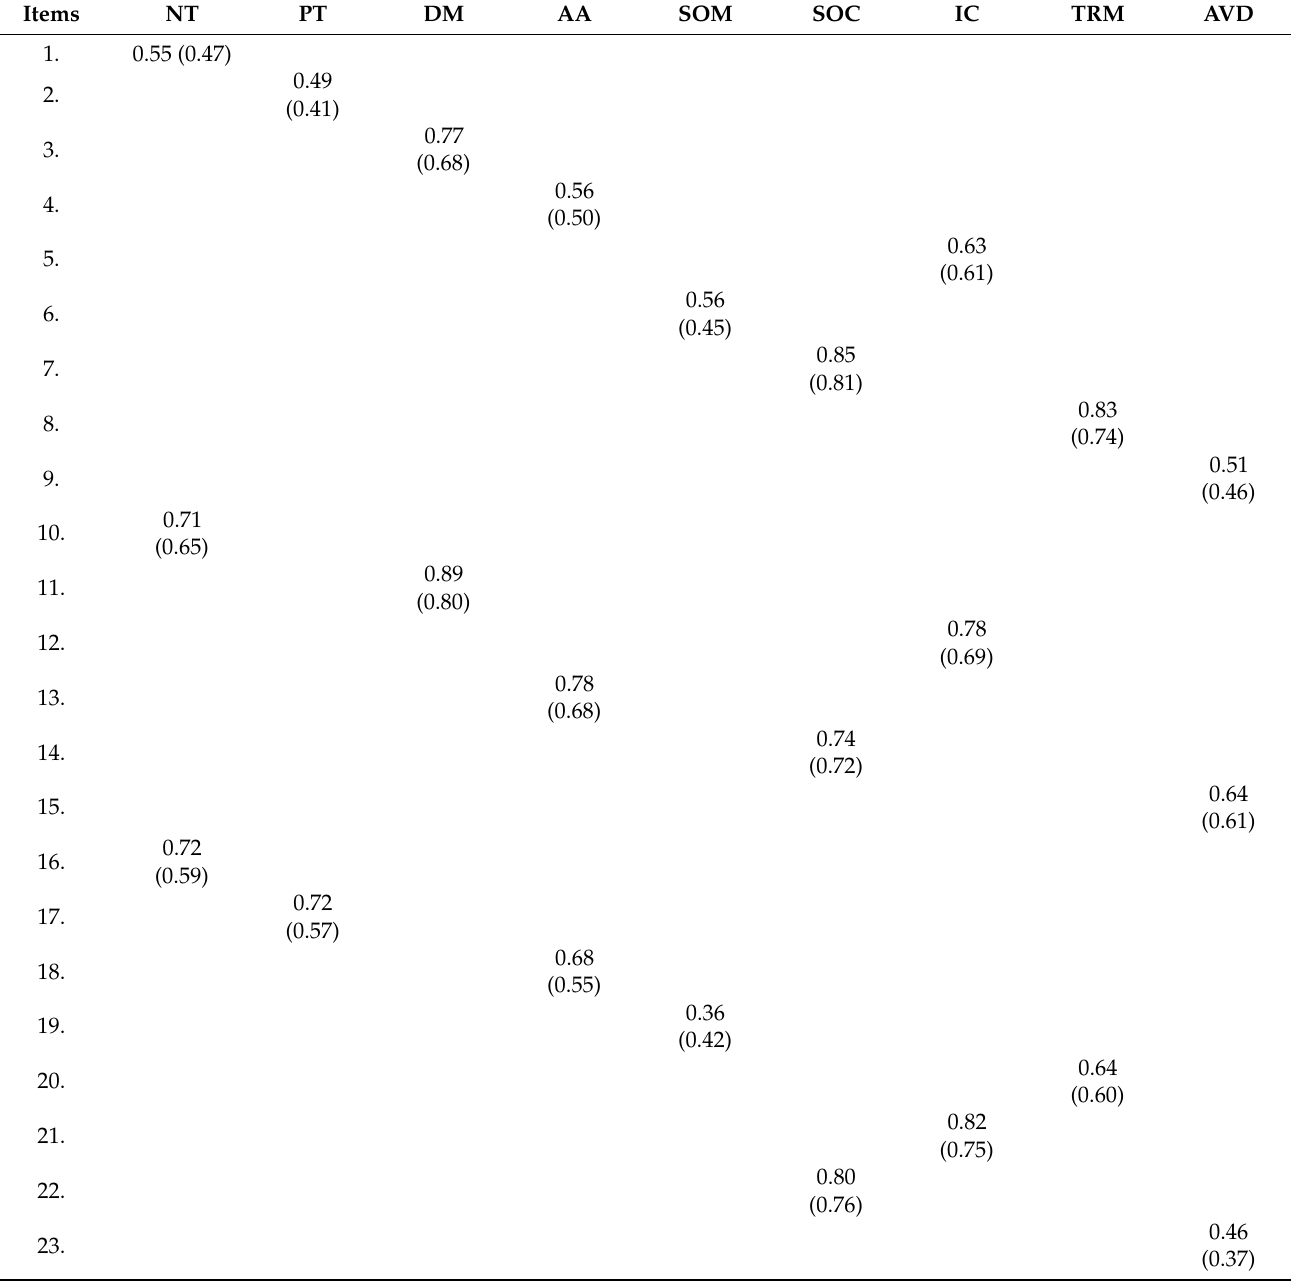
Table 3. Factor loadings and discrimination indices of the MEDI items ( n =